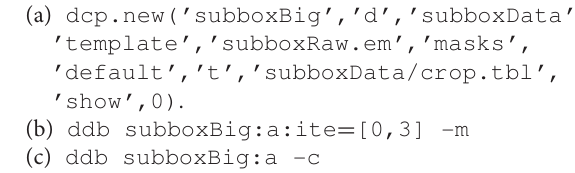
FIGURE 6 | Subboxing STA project. Visual pipeline describing the basic steps taken during the subboxing STA project to obtain detailed ultrastructural information of asymmetrical subunits. (A) Y view in dmapview of the average obtained in STA project localized to measure the distance between the crown [red circle, (C) button inside the red boxed area] and the tooth (blue circle, N button inside the red boxed area). (B) Graphical representation of the particles contained in the sub boxed table (dynamo_subboxing_table) . Black points represent the subunits around the crown structure and black lines show their corresponding normal vector. (C,D) Z and Y view of the average obtained after performing daverage with the subboxed particles, respectively. (E,F) Z and Y view of the average obtained after performing daverage with the subboxed particles and applying the mask dynamo_sphere , respectively. (G) Numerical parameter used in the subboxed STA project (dcp subboxBig) . (H) Graphical representation of the angle search mode defined in (G) concerning cone aperture and cone sampling as well as azimuthal rotation range and azimuthal sampling angles. (I) Density map of the average result of the execution of the subboxed STA project displayed in chimera (dchimera) , red arrowheads indicate the revealed teeth surrounding the